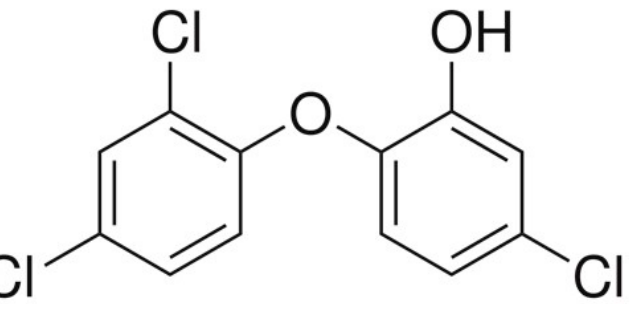
Figure 1. Structure of triclosan (TCS).